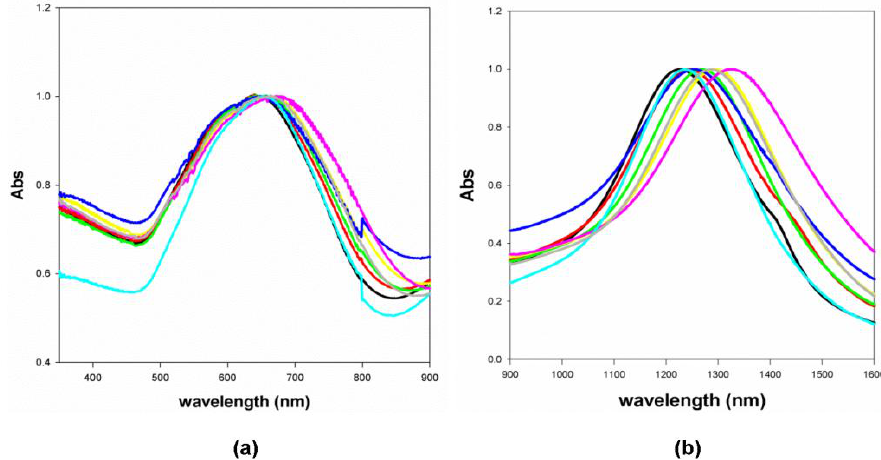
Figure 7. Normalized absorption spectra (a: LSPR2, b: LSPR3) of GNS suspended in different solvents. Black: water (n = 1.3300); light blue: acetonitrile (n = 1.3442); red: ethanol (n = 1.3611); blue: ethyl acetate (n = 1.3723); green: n -butanol (n = 1.3990); grey: N,N-dimethylformamide (n = 1.4300); yellow: chloroform (n = 1.4476); magenta: toluene (n =